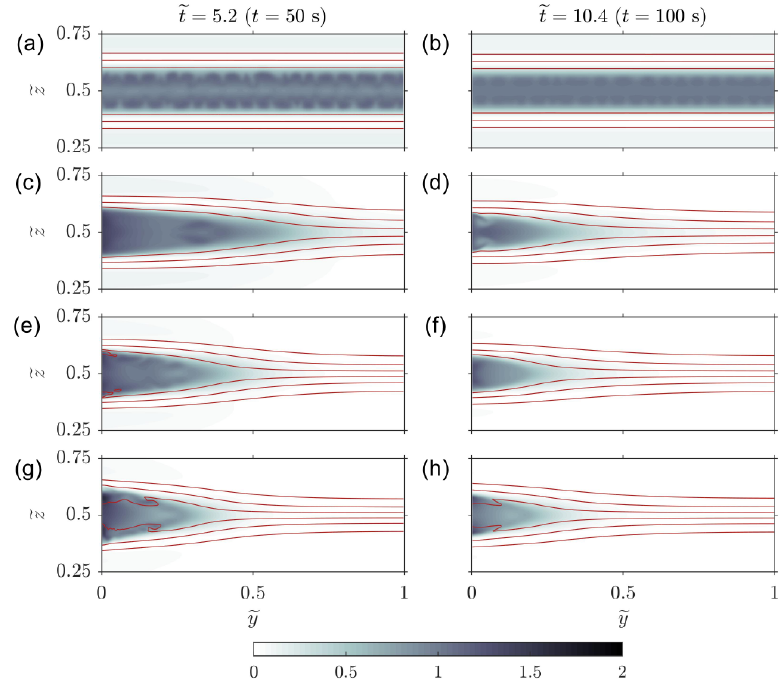
Figure 12. Kinetic energy density at the location of maximum amplitude for f/f 0 = (a, b) 0, (c, d) 1 / 4, (e, f) 1 / 2, and (g, h) 1. Red contours are the same as in Fig. 9. All cases have Sc = 10.